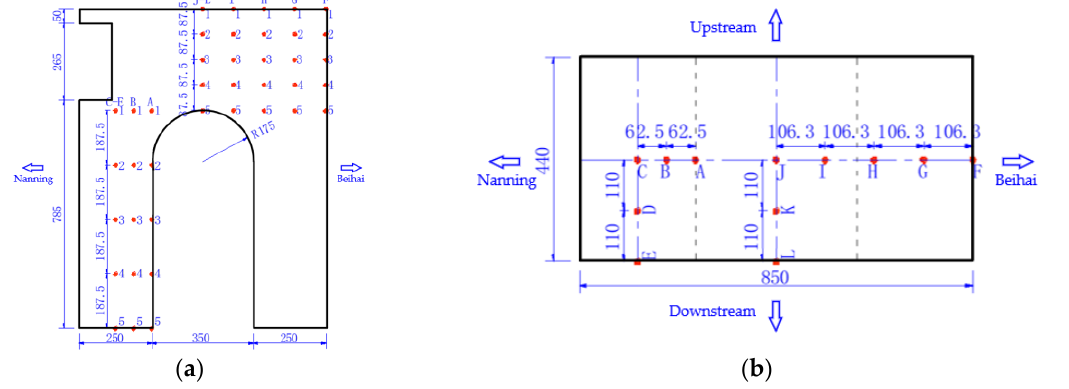
Figure 6. The arrangement of temperature monitoring points for mass concrete in main pier: ( a ) elevation; ( b ) plan (unit: cm).